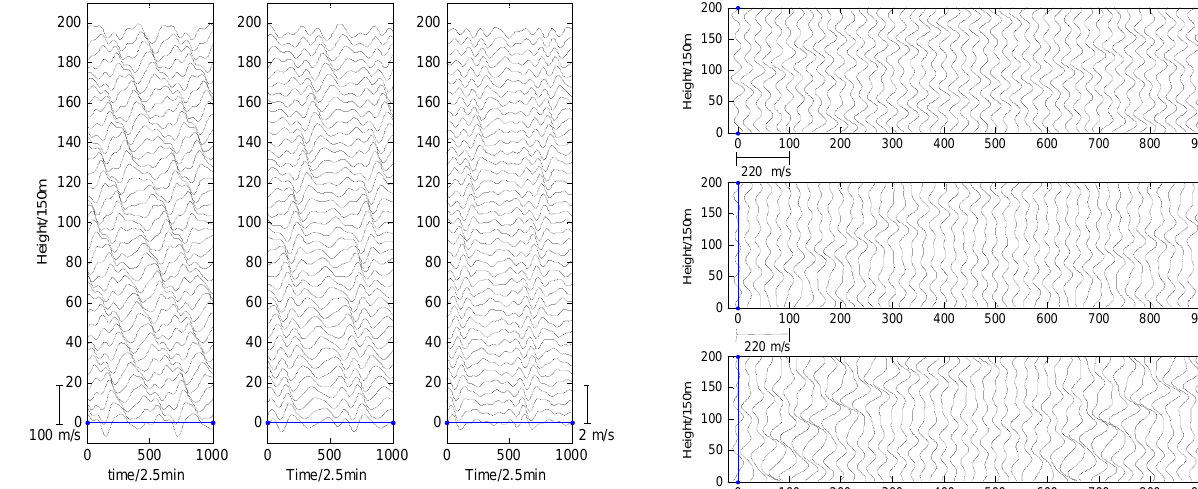
minor axis ratio yields an intrinsic period of 15.45 h, and its major axis lay along the direction with ϕ az = 63 . 3 ◦ . This intrinsic period is larger than each of the original wave